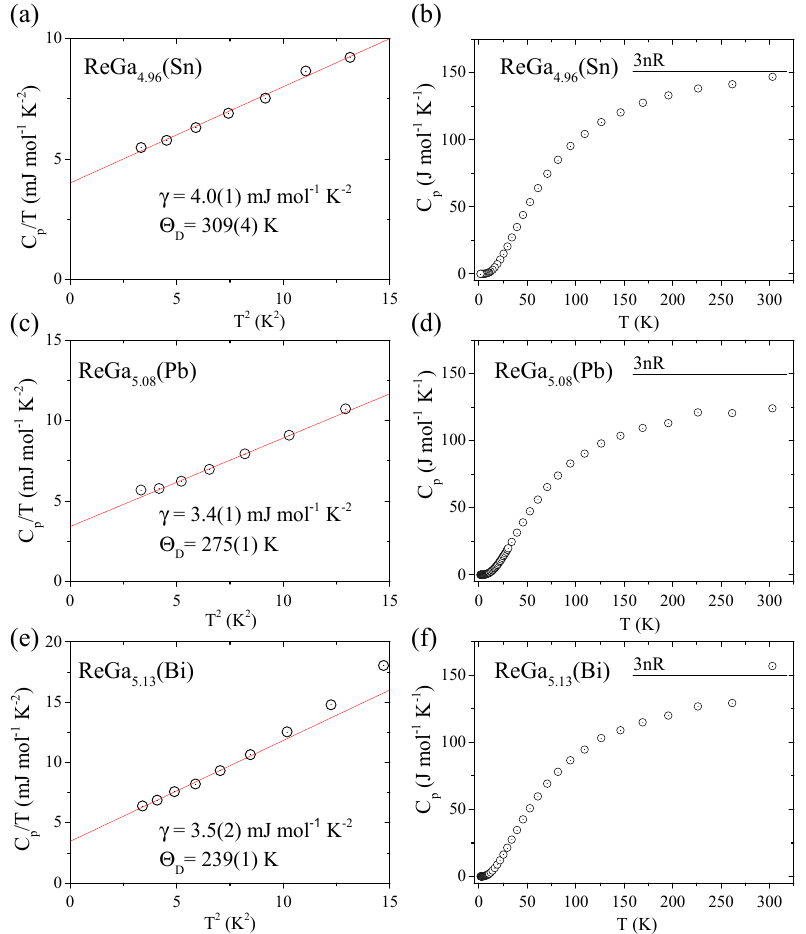
Figure 3. ( a , c , e ) Heat capacity (C p (T) / T ~ T 2 ) range 1.85 to 300 K for ReGa ~5 (Sn), ReGa ~5 (Pb) and ReGa ~5 (Bi) to obtain the Sommerfeld parameter ( γ ) and Debye temperature ( θ D ). ( b , d , f ) Heat capacity (C p (T) ~ T) range 1.85 to 300 K for ReGa ~5 (Sn), ReGa ~5 (Pb) and ReGa ~5 (Bi).